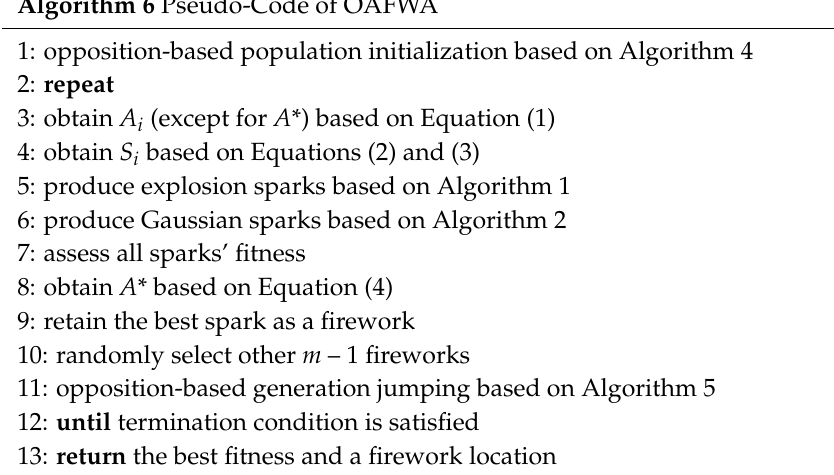
Algorithm 6 Pseudo-Code of